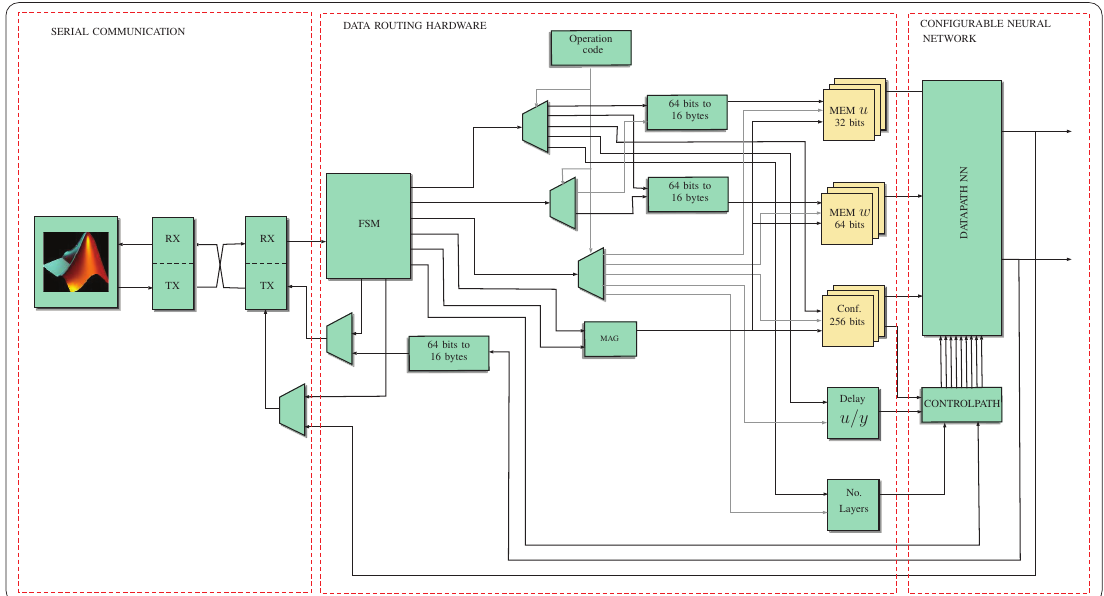
Figure 3. Configurable MFNN